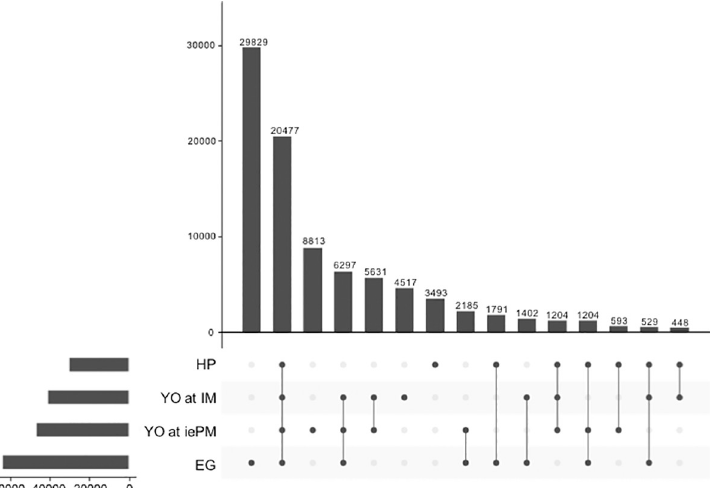
Fig 2. UpSet plot depicting the number of unique and shared transcripts with TPM � 1 in each tissue. Intersection size represents the number of transcripts for each designated sets or groups. The dots and lines illustrate the groups defined as: HP: Hepatopancreas, YO at IM: Y-organ at intermolt, YO at iePM: Y-organ at induced early premolt and EG: Eyestalk ganglia.